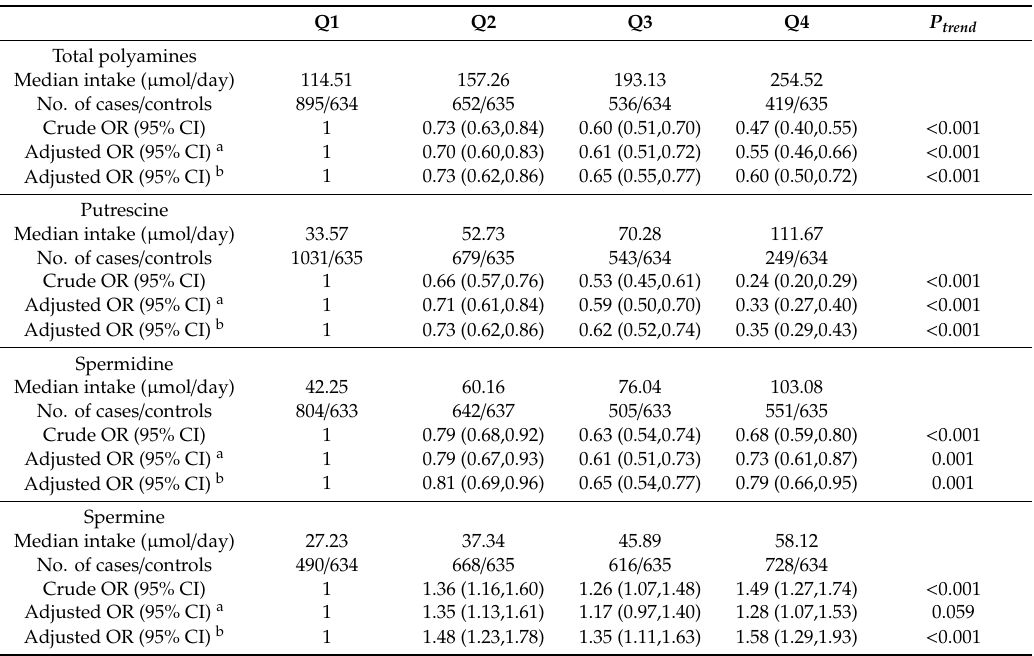
Table 3. Risks for colorectal cancer according to quartiles of polyamines intake (Odds ratios and 95% confidence